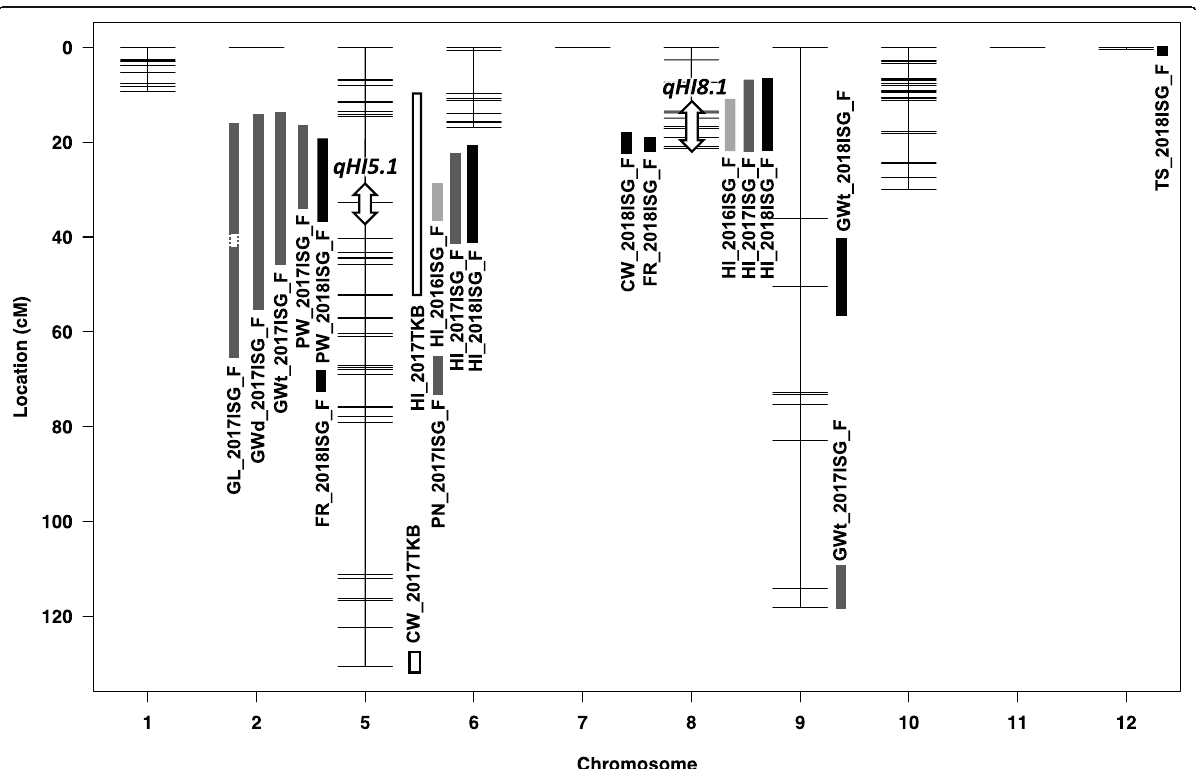
Fig. 3 Linkage map developed by the genetic analysis of RILs and QTLs identified in this study. The vertical bars indicate the range in which the LOD value of each QTL exceeds the threshold. The double-headed arrows on chromosomes 5 and 8 indicate the putative region where the responsible genes for HI would be located. Abbreviations are as follows: Panicle weight (PW), culm and leaf weight (CW), grain weight (GWt), grain length (GL), and grain width